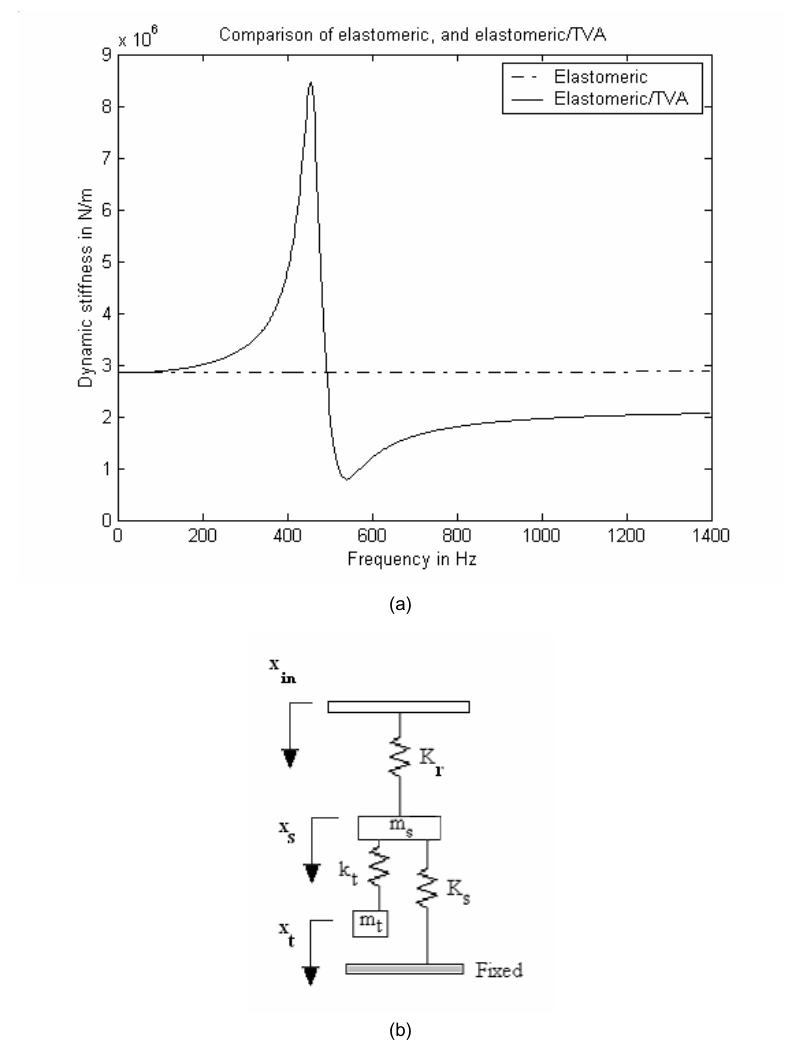
Fig. 11. (a) Rubber mount (dashed) versus Rubber Mount/TVA (solid). (b) Simplified model of a rubber mount, fuselage structure and